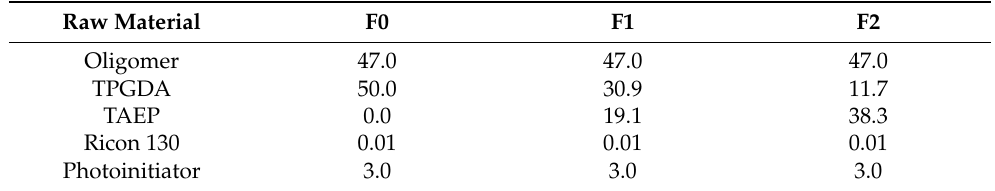
Table 1. Composition of the UV-curable wood coating formulations. Raw